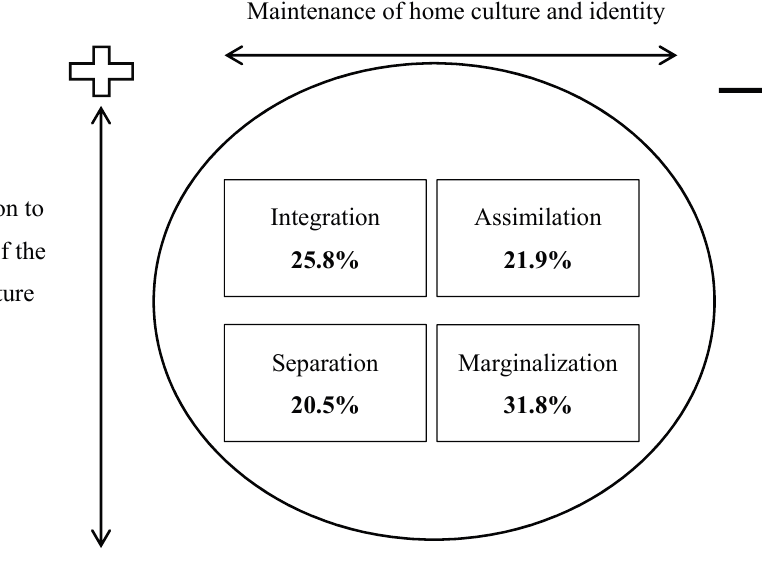
Figure 2. Relative categories of cultural orientation of